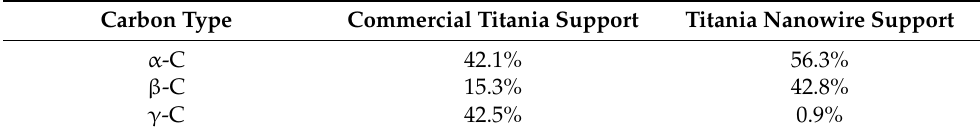
Table 1. Distribution of different types of carbon residues present.